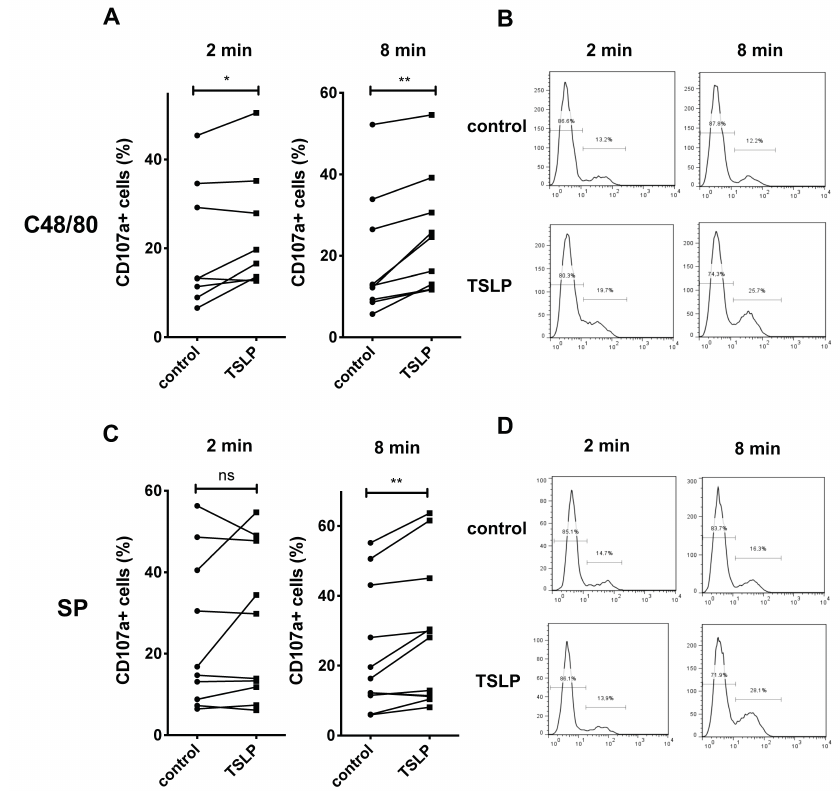
Figure 2. TSLP modestly increases the proportion of CD107a+ cells following MRGPRX2 triggering. MCs were pre-treated with or without TSLP (7.5 ng/mL), then stimulated with c48/80 (10 µ g/mL) or SP (30 µ M) for 2 min and 8 min, respectively; CD107a cell surface expression was determined by flow- cytometry. MCs from the same preparation are shown as interconnected dots ( A , C ). ( A ) Stimulation by c48/80, cumulative data. ( B ) Representative histogram of A. ( C ) Stimulation by SP, cumulative data. ( D ) Representative histogram of C. The data are from 8—11 independent experiments. * p < 0.05, ** p < 0.01, ns, not